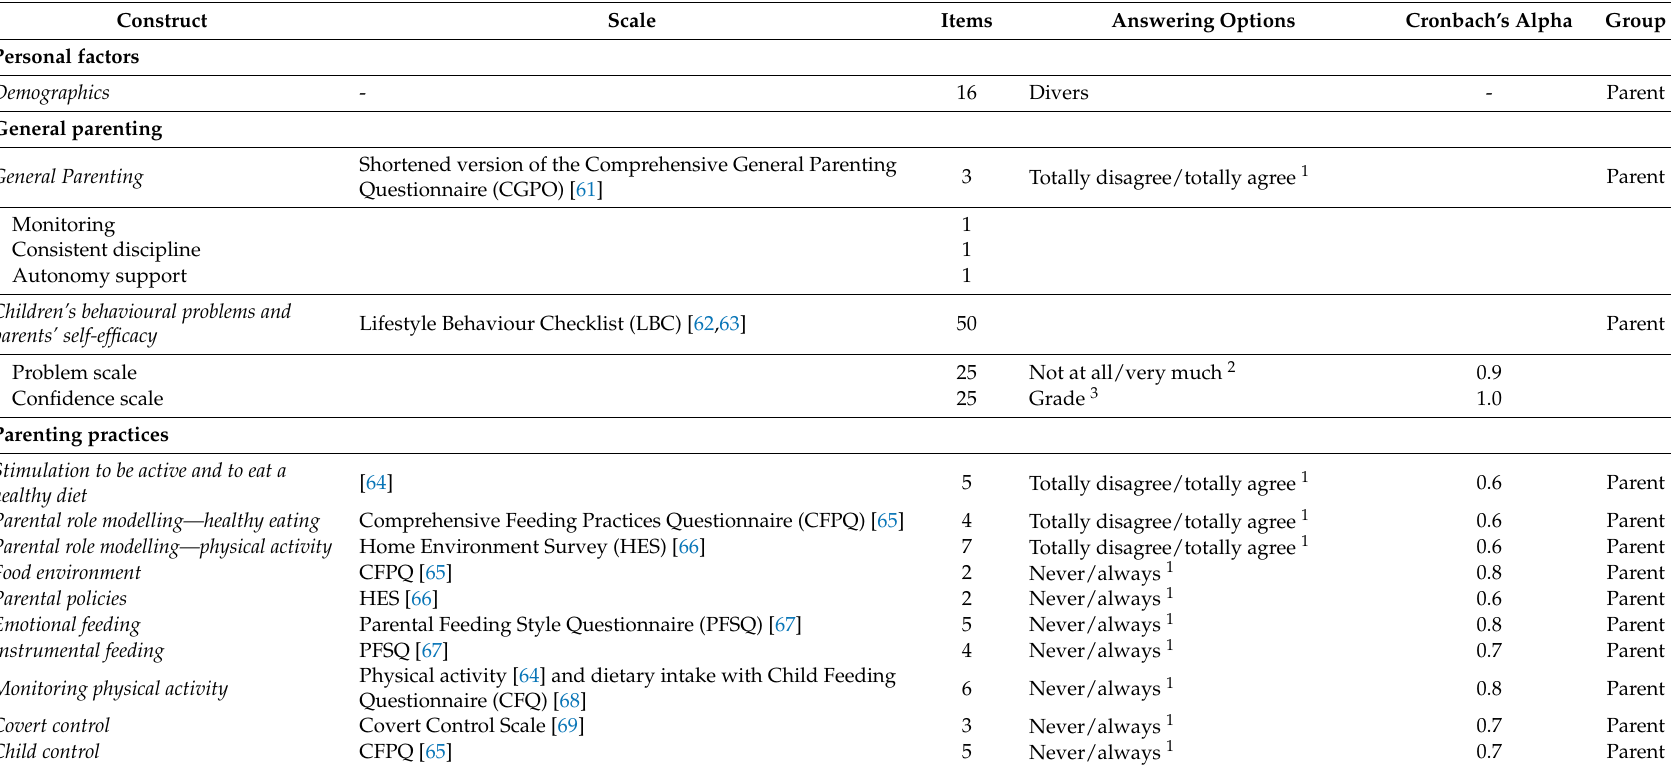
Table A3. Constructs used in the questionnaires for the children and their parents, with their corresponding scales. Construct Scale Items Answering Options Cronbach’s Alpha